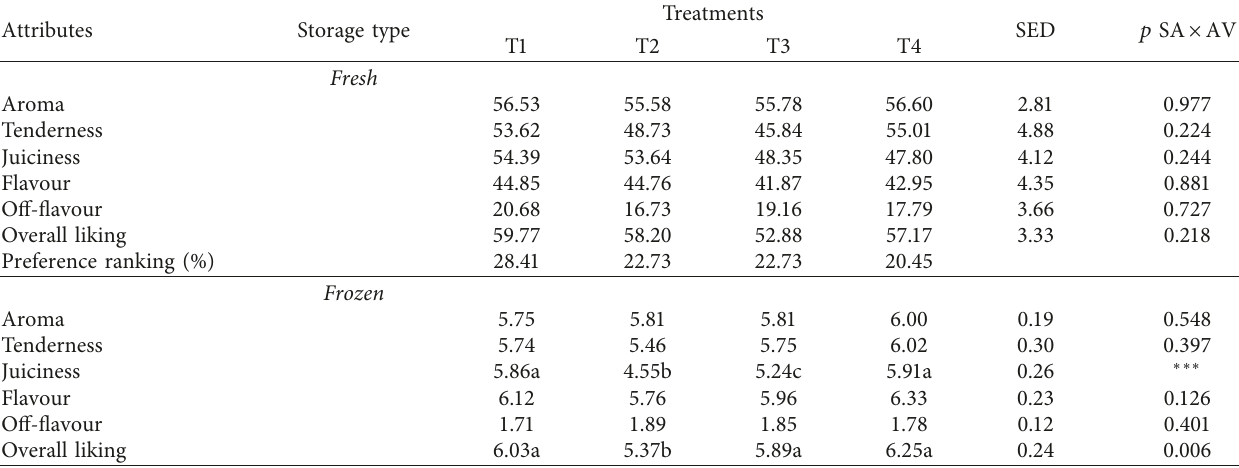
Table 7: Effect of ageing treatment combinations and frozen storage on sensory acceptability of in-bag dry-aged lean beef for 21days.